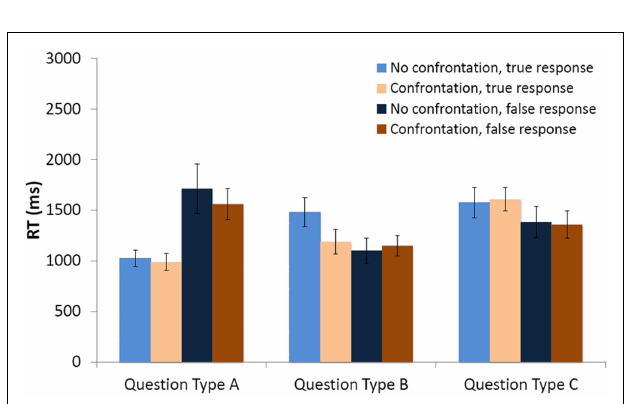
FIGURE 4 | Mean response times (RT) to answer the opponent’s question. Separate means are given for false and true responses, and for responses given both when the opponent could and could not confront the response. Error bars represent one